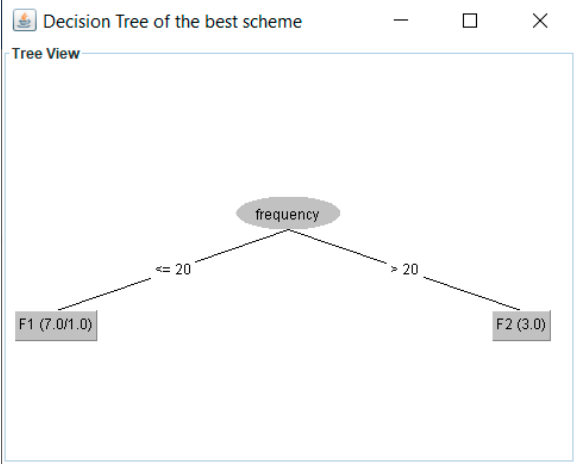
Figure 13. Decision tree for 2 fragments found by FTree in the third experiment.